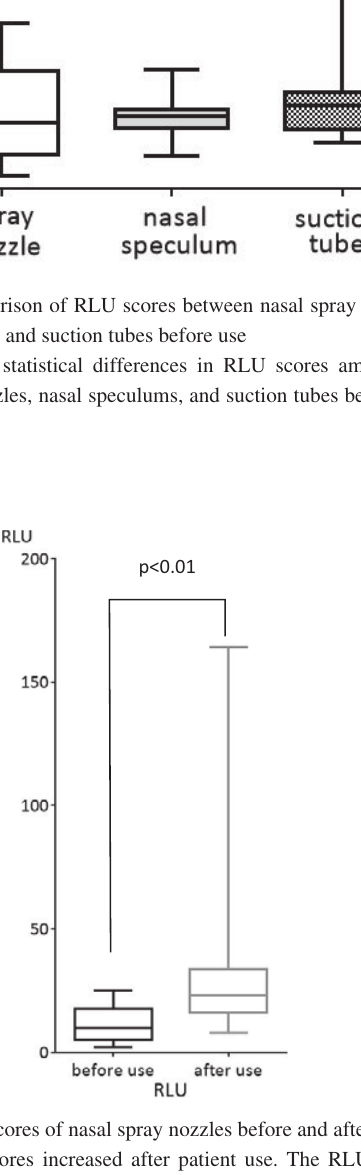
F i g . 4 RLU scores of nasal spra y nozzles before and after u se Nozzle RLU scores increased after patient u se. The RLU scores (mean ± SD) of the nasal spra y nozzles before u se w as 12 ± 7.1